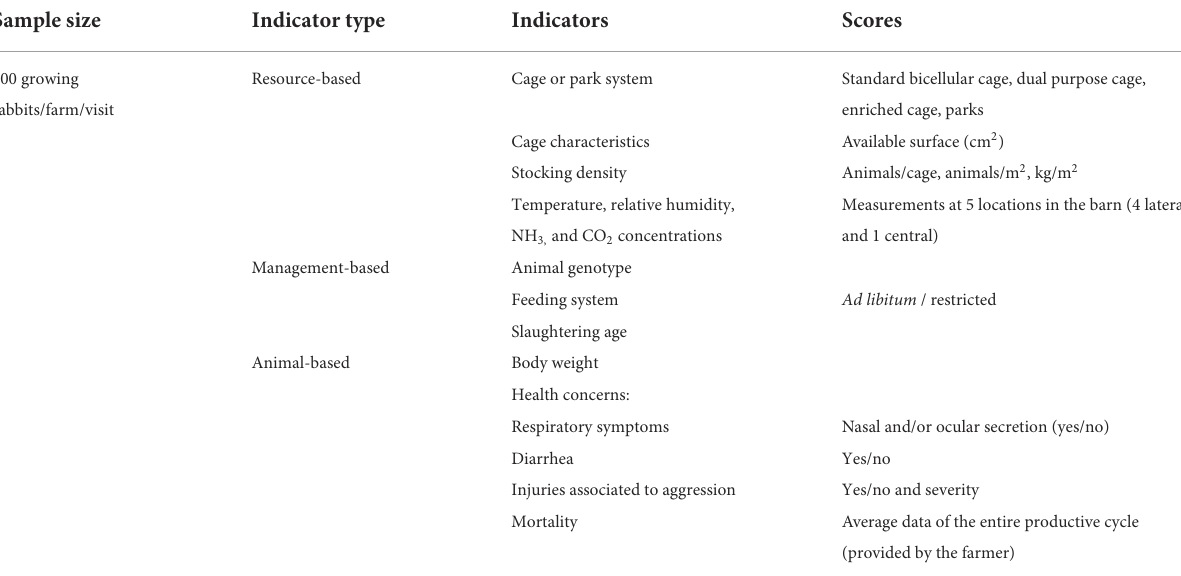
TABLE 3 Health and behavioral animal-based indicators and resource- and management-based data recorded on farms with growing rabbits before slaughtering (pre-slaughtering